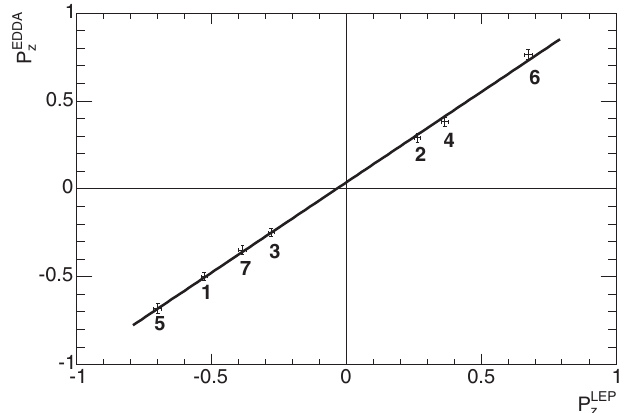
FIG. 2. Comparison of the measurements of the vector polar- ization of the deuteron beam from EDDA and LEP for the seven states of the source, listed in Table I. The best fit straight line to the data is also